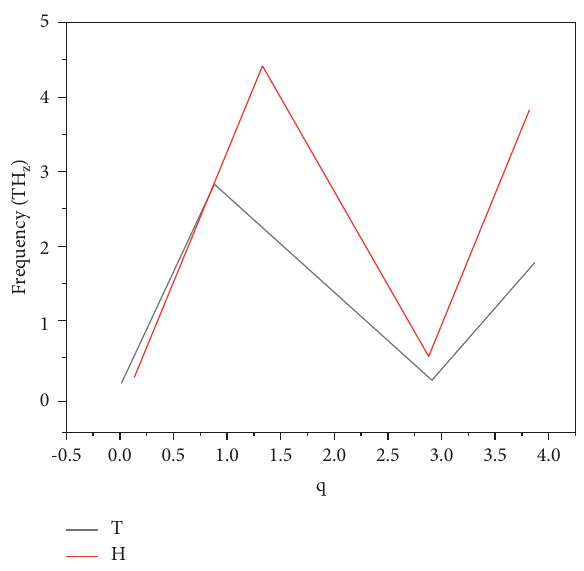
Figure 6: Phonon dispersion curve q of Au